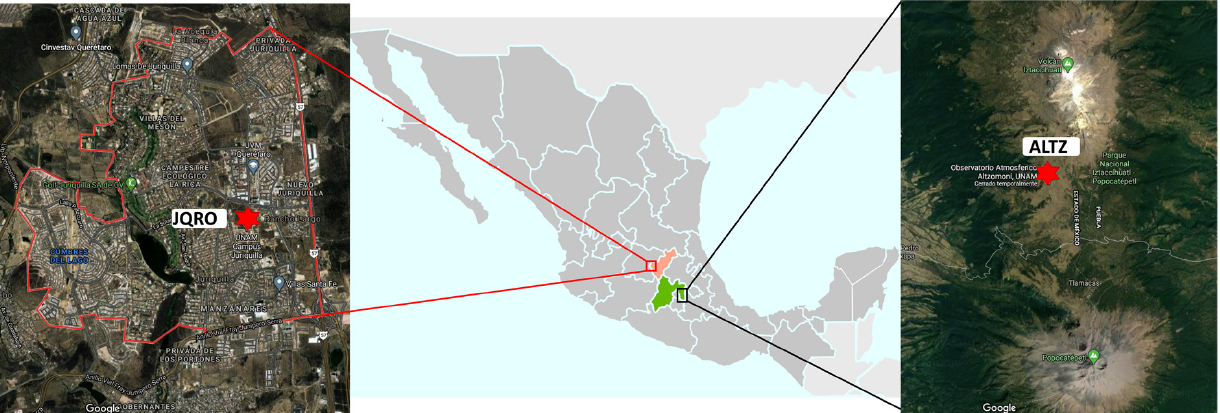
Figure 1. National Park (ALTZ) and semi-urban (JQRO) sites.